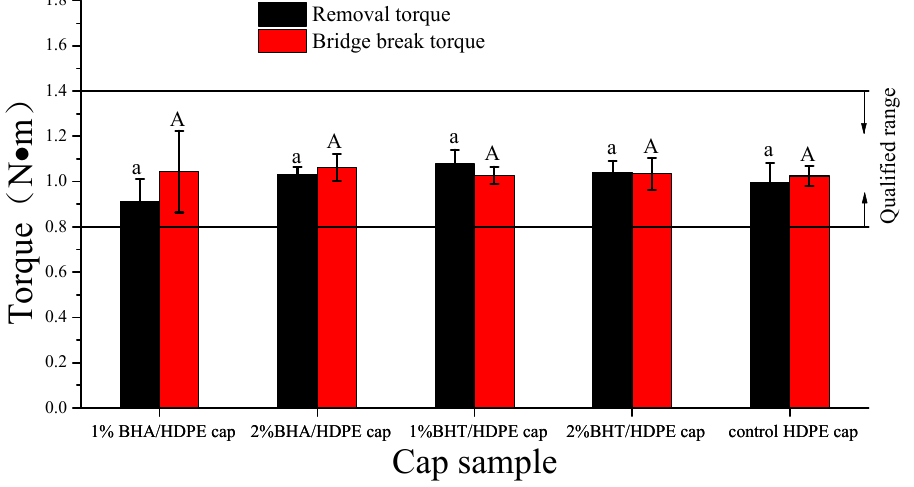
Figure 5. Removal and bridge break torques of antioxidant active plastic bottle caps ( n = 3).